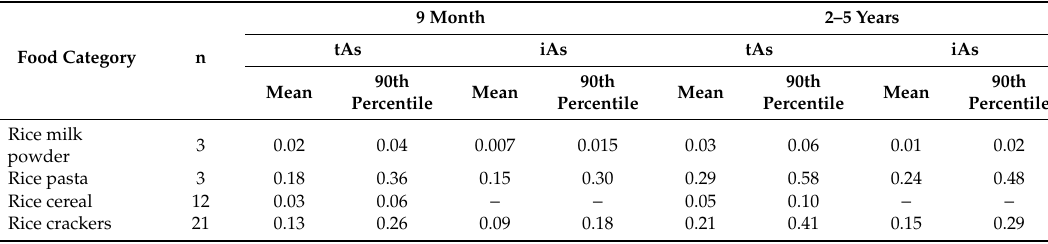
Table 4. Mean and 90th percentile dietary exposure of total arsenic and inorganic arsenic ( µ g kg − 1 b. wt. day − 1 ) for 9 month and 2–5 year-old